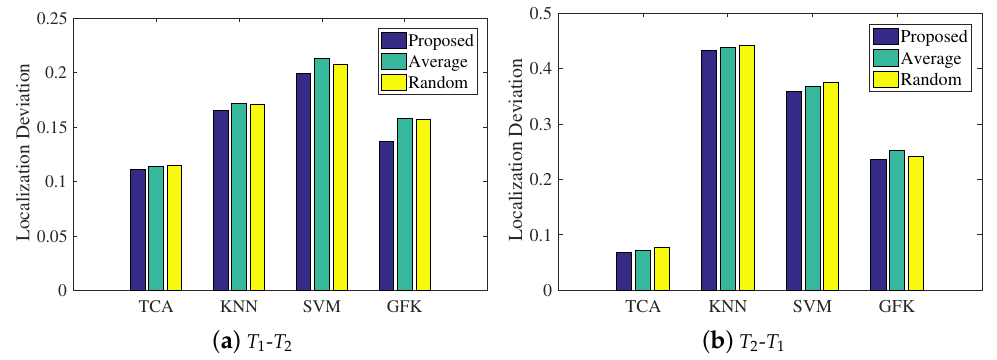
Figure 13. Impacts of the weighted coefficient on localization performance: ( a ) training with the T 1 dataset and testing on the T 2 dataset; ( b ) training on the T 2 dataset and testing on the T 1 dataset.